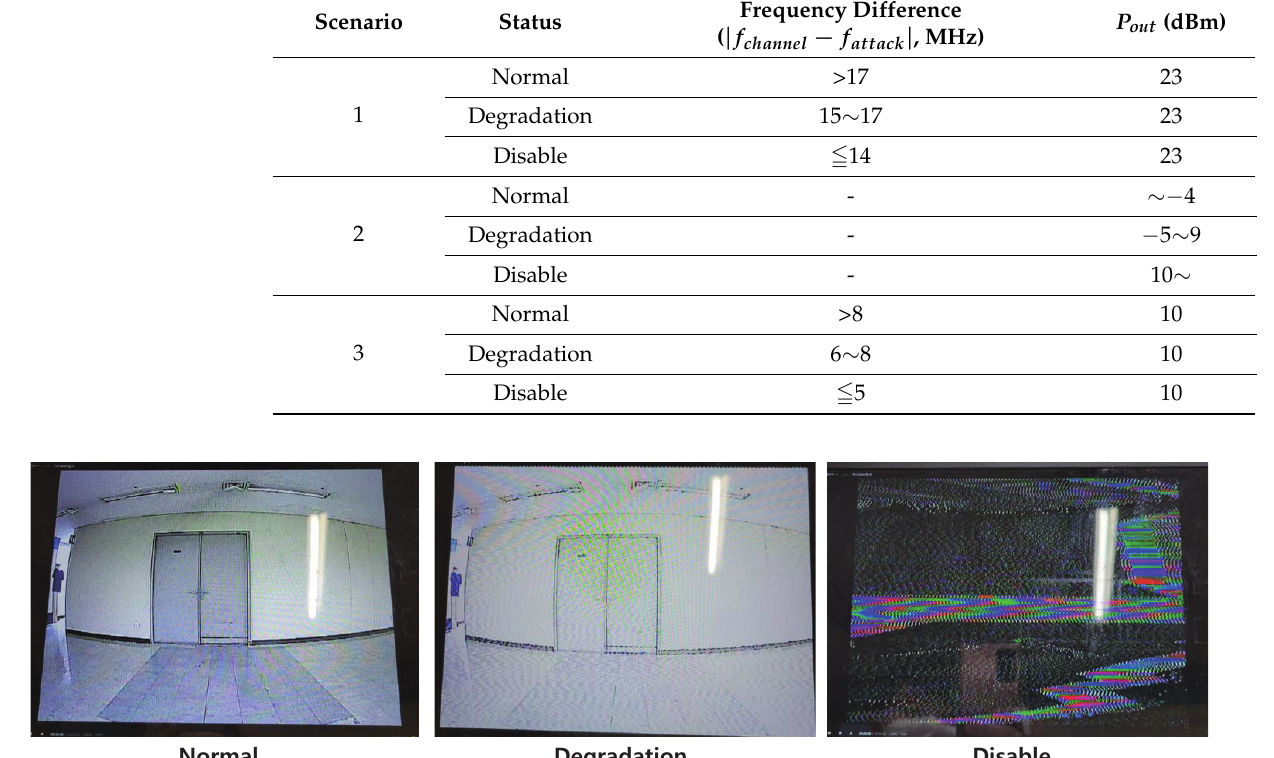
Table 7. Experiment results of low power IEMI on camera module using analog communication scheme.